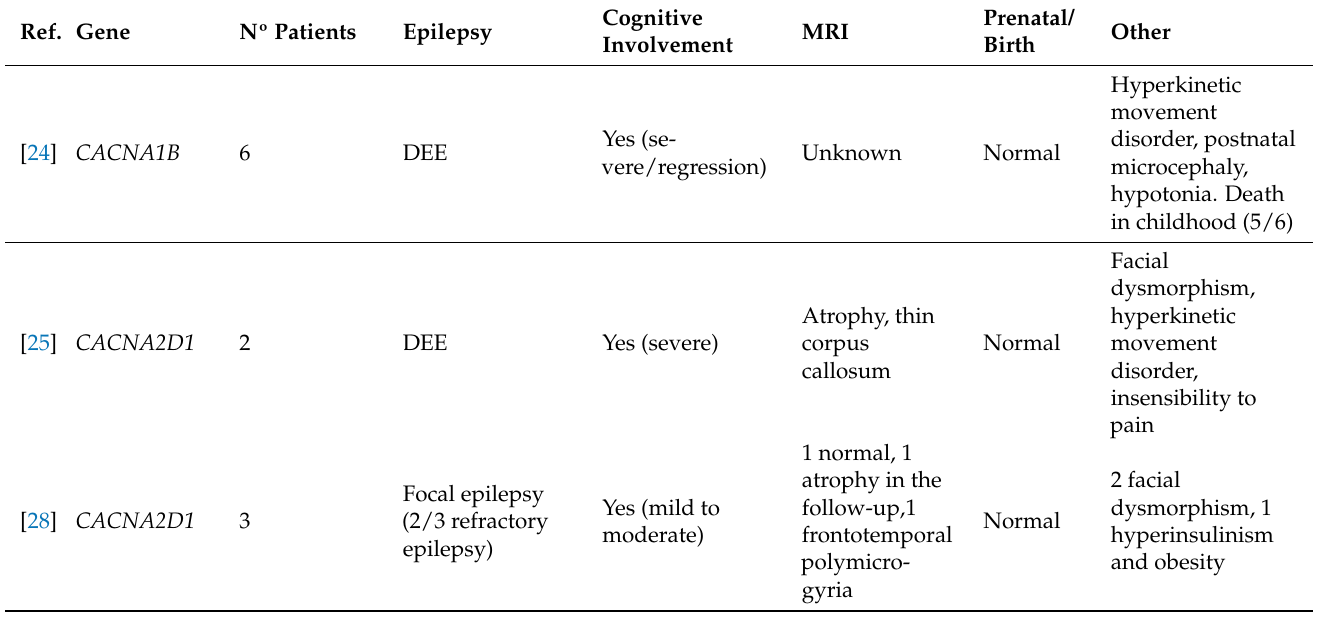
Table 4. Summary of the clinical presentation of the reported cases with epilepsy and genetic alterations in the N-type Ca